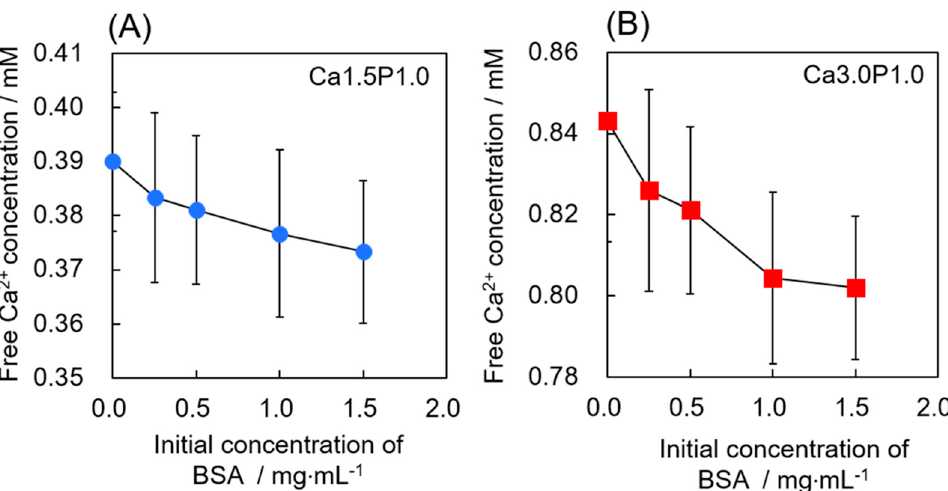
Figure 2. Change in free Ca 2 + concentration from 0 to 1.5 mg · mL − 1 BSA in Ca1.5P1.0 ( A ) or Ca3.0P1.0 ( B ) solutions. Mean values were obtained from three independent experiments (n = 3).